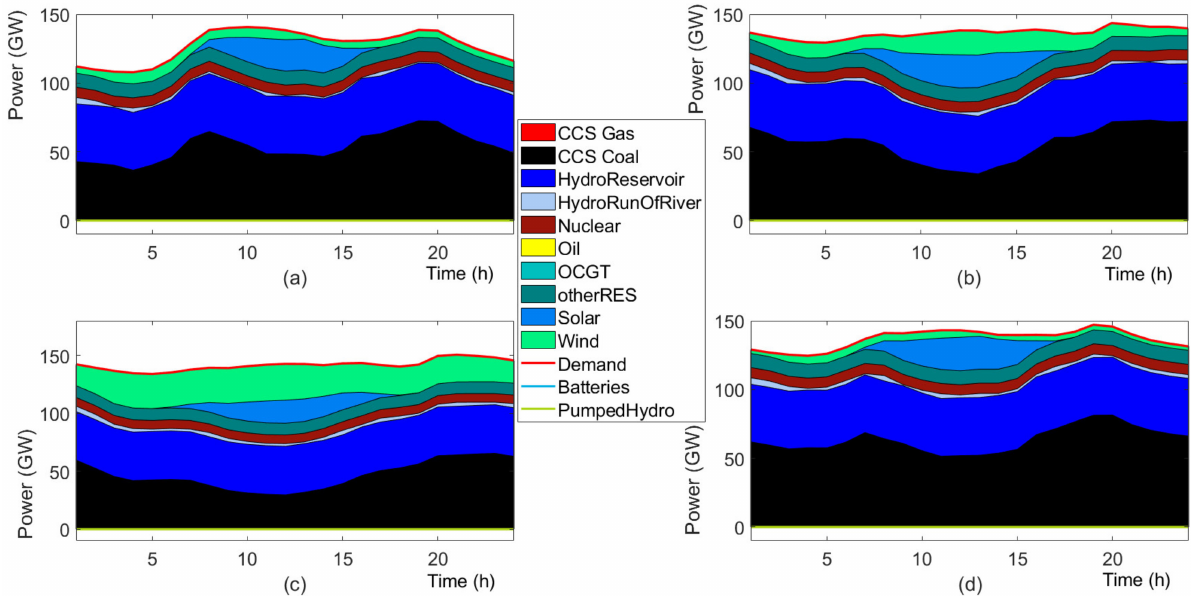
Figure 12. Generation mix in the year 2020 (specifically, scenario-tree node 1), with the availability of storage, in four typical days. Figure ( a ) reports a typical day within the period January–March, ( b ) a typical day within April–June, ( c ) a typical